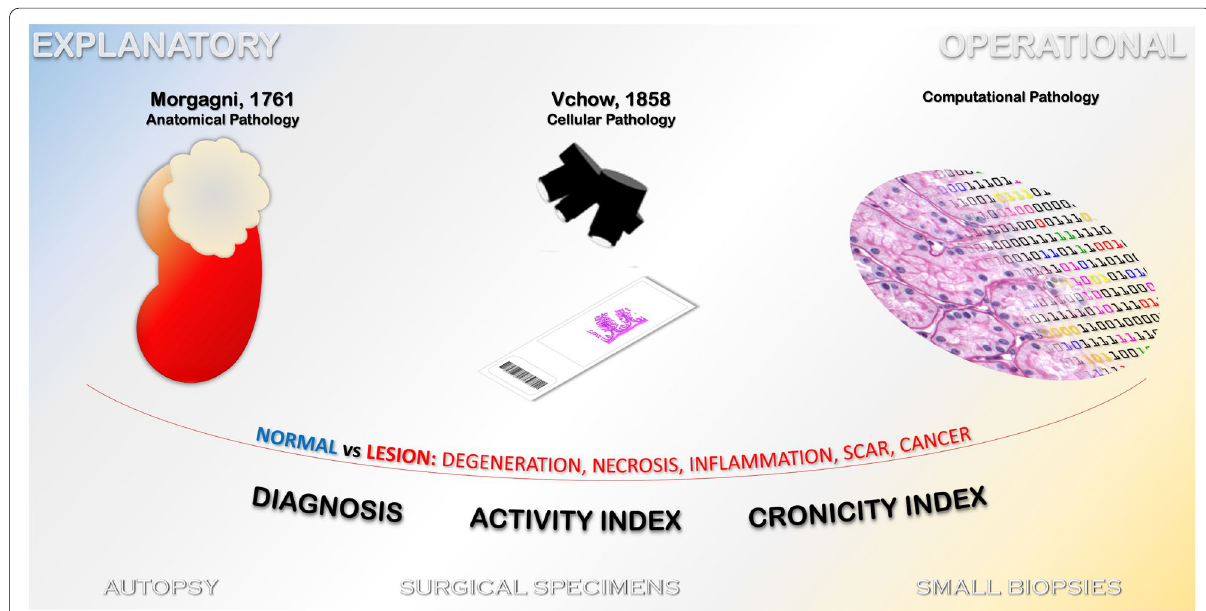
Fig. 1 Three moments in Anatomical pathology: The foundation as an area of medical knowledge, marked by the publication of “De Sedibus et Causis Morborum per Anatomen Indagatis” by Morgagni in 1761. The second moment is represented by the conception of Cellular Pathology and the publication of Virchow’s lectures in 1858. Computational Pathology represents a possible future in pathology. The two previous moments produced, and the third, in perspective, should produce important changes in the pathologist’s environment, routine activities (macroscopic examination, microscopy and computational analysis), and object of